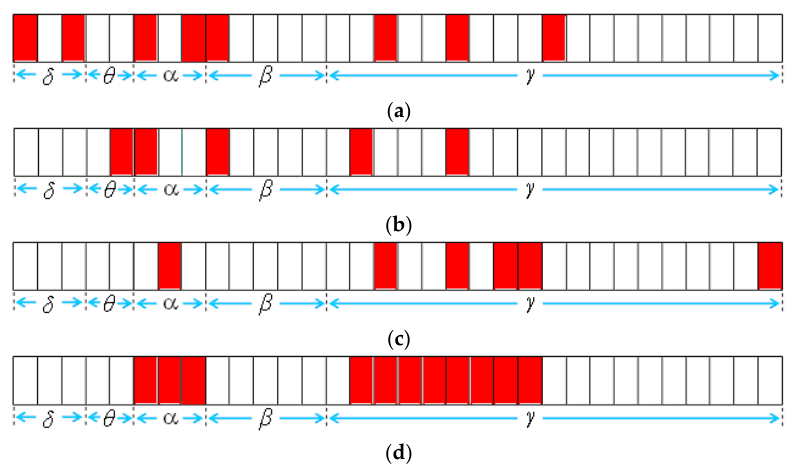
Figure 9. Feature vectors selected by ( a ) information gain (IG); ( b ) sequential floating search (SFS); ( c ) sequential forward floating search (SFFS); ( d ) neighborhood-relationship feature selection (NRFS). Table 5. Experimental results of original data set of EEG signals.